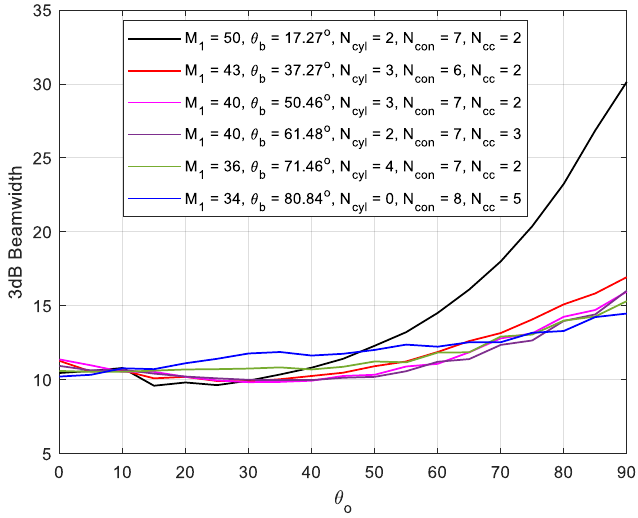
Figure 11. Half-power beamwidth variation with mainlobe direction at different CSC 4 array designs with fixed array size of 334 elements.